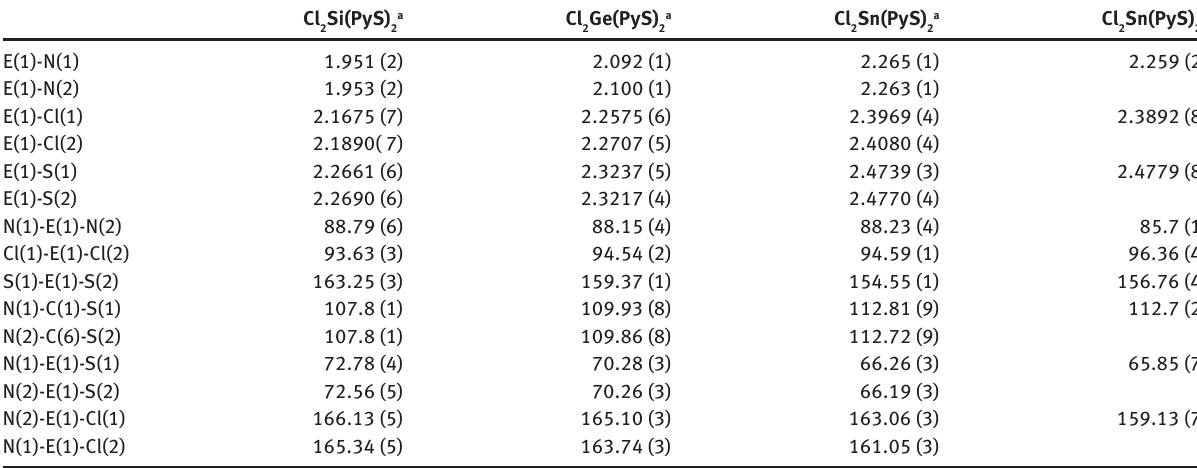
E(PyS) (E = Si, Ge, Sn). 2 2